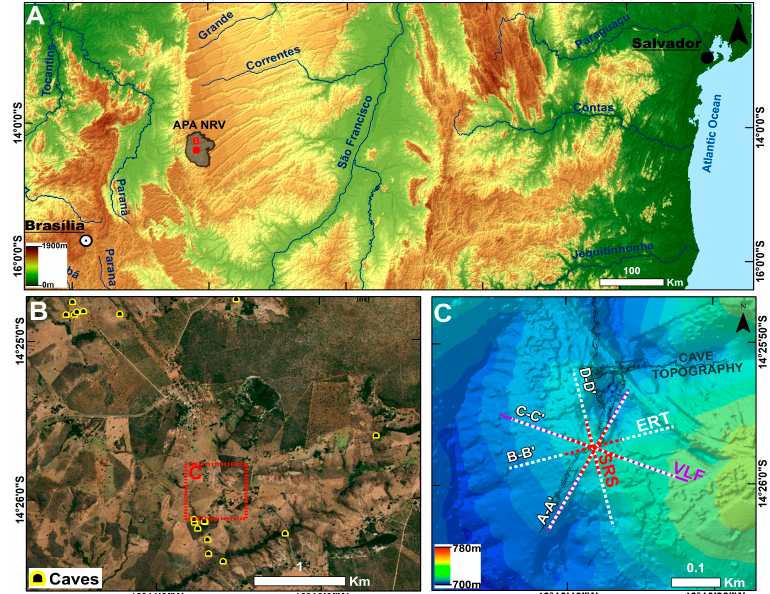
Figure 1. ( A ) The administrative boundary of the environmentally sensitive area of the River Vermelho on the map of Brazil, ( B ) location of the study area on the Tarimba cave, and ( C ) the locations of geophysical profiles (ERT, SRS, and VLF-EM) on zoomed Trimba Cave map.